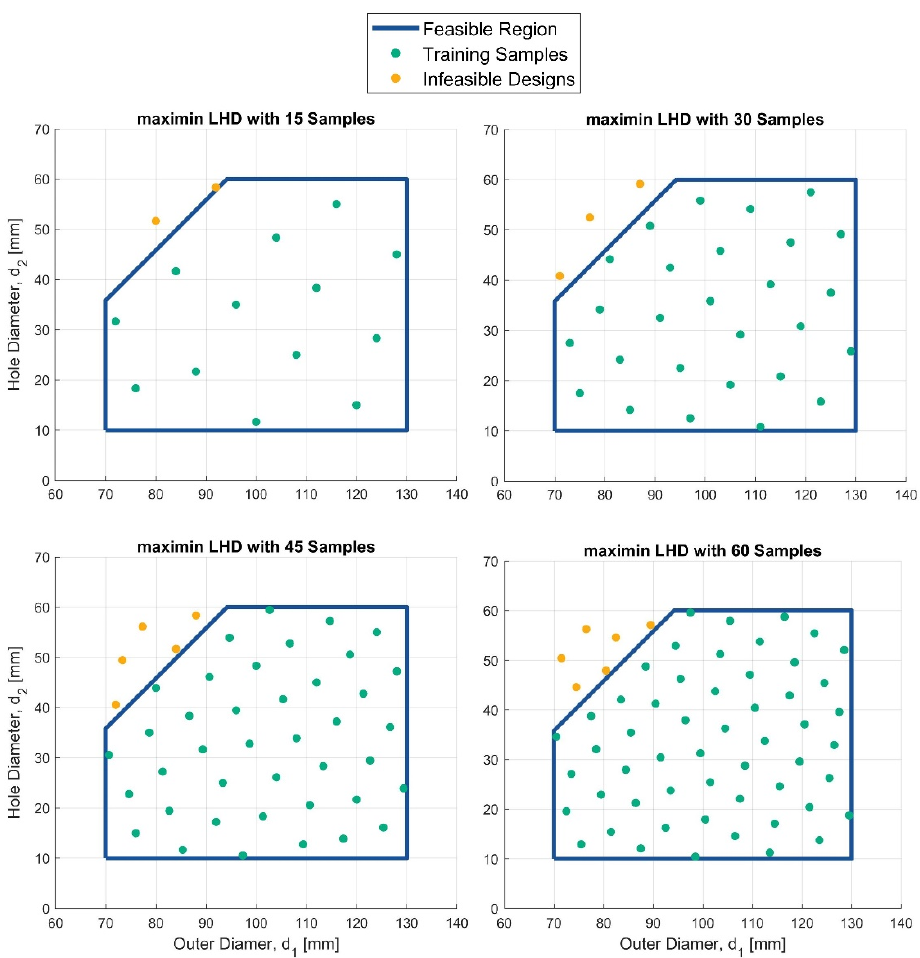
Figure 6. The distribution of the selected training data points in the design area using maximin Latin hypercube Design with different numbers of samples.